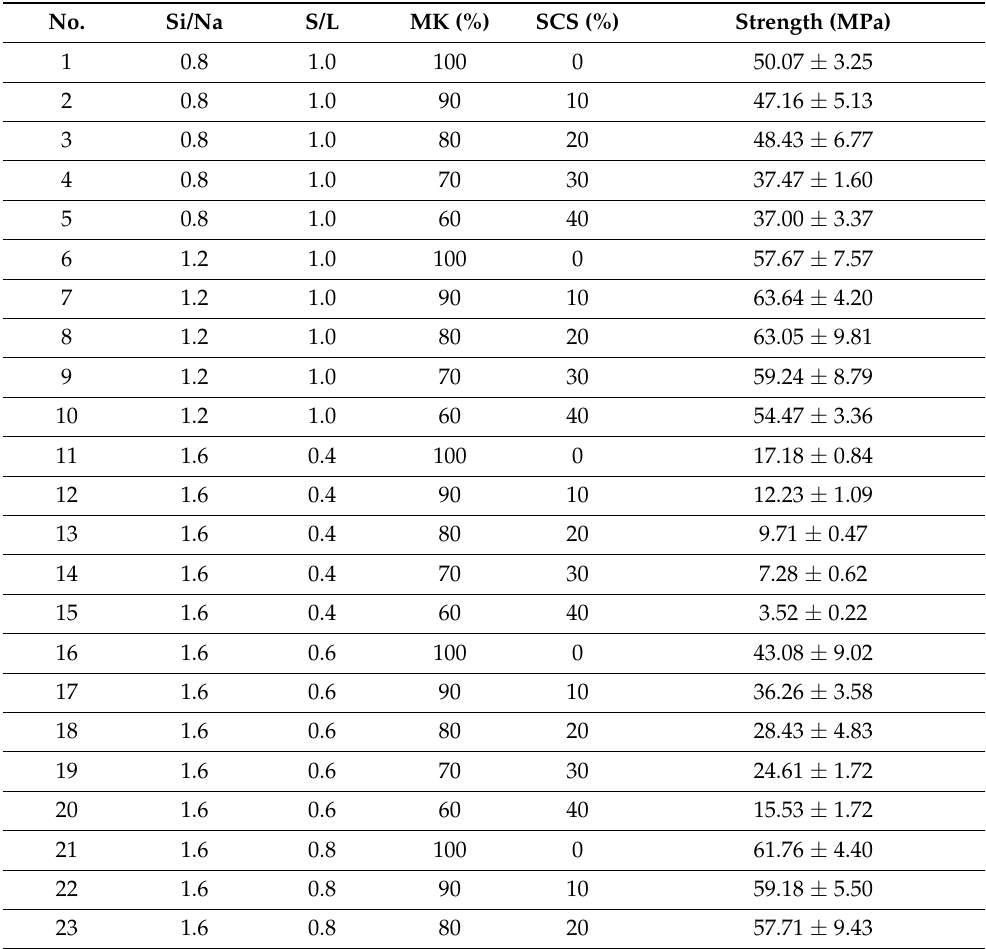
Table 2. Mix design and compressive strength of the thirty-five (35) runs for SCSGPs. No.